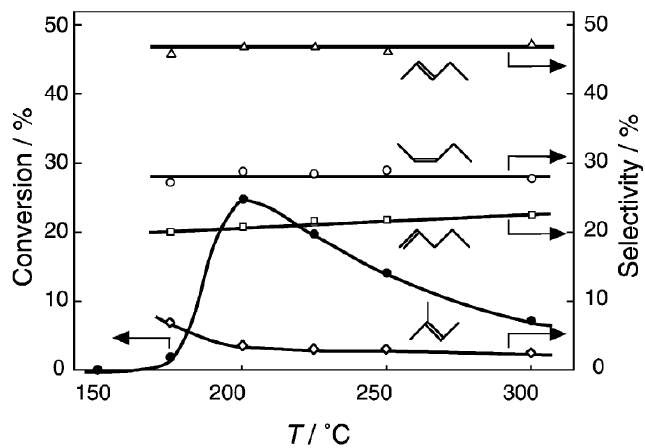
Cl (30 mg, 34 μmol) in helium at 5 3 9